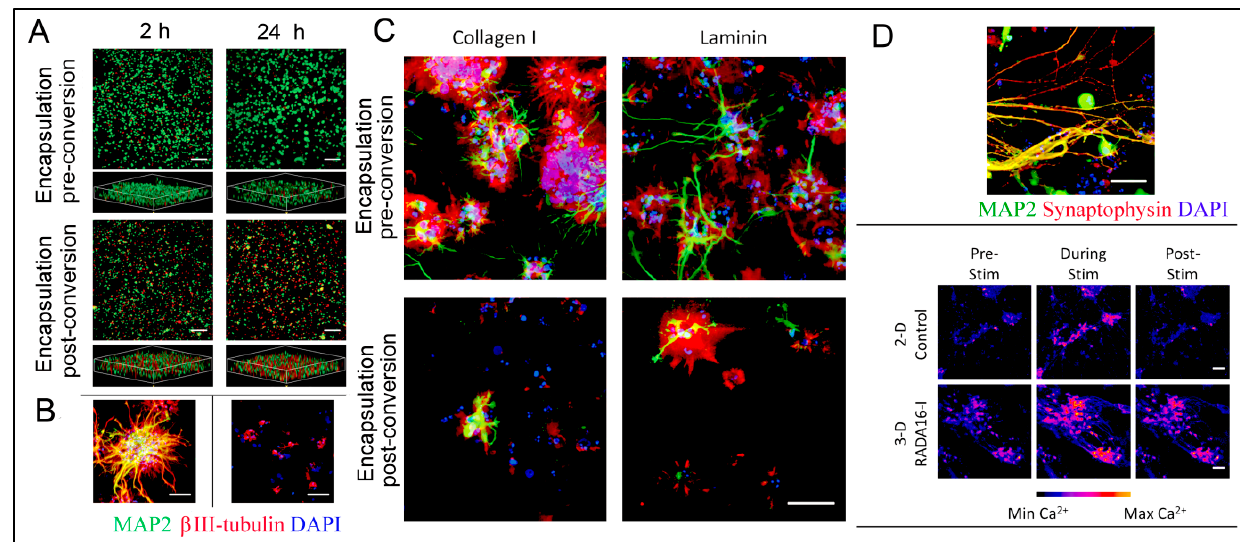
Figure 14. Reprogramming and transplantation of hPSC-derived neurons supported by SAPNS hydrogels. ( A ) Live/dead assay of cells encapsulated in RADA16-I SAPNS hydrogels. ( B ) Immuno- chemical assay revealed neurite outgrowth at pre-induction and post-induction. ( C ) Secretion of collagen I and laminin by hydrogel-encapsulated iPSCs. ( D ) Immunocytochemical assay of neuron maturing with synaptophysin expression ( up ) and live-cell calcium images from time-lapse videos ( bottom ). Reprinted with permission from Ref. [286], Copyright 2016, American Chemical